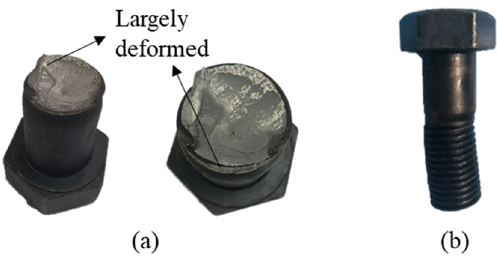
Figure 8. Failure shape of anchor bolt: ( a ) typical fracture, ( b )